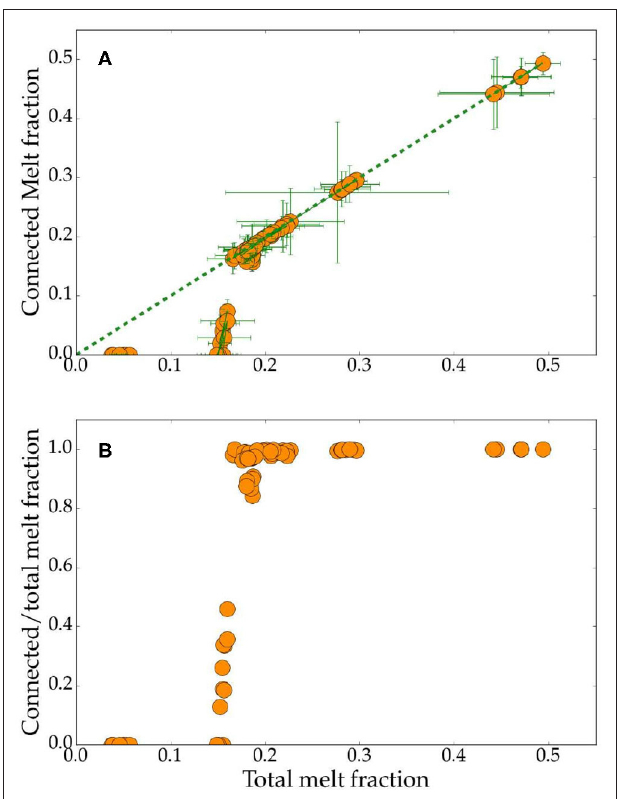
FIGURE 6 | Plots of (A) median coordination number and (B) pore equivalent radius as a function of melt volume fraction in all subvolumes. The horizontal axis represents values of connected melt fraction for the filled squares and total melt fraction for filled circles. Error bars for melt volume fraction are given by the difference between automatically thresholded and manually thresholded melt fractions. Error bars for coordination number and pore radius are given by the standard deviation (1 σ ) of the measured values of